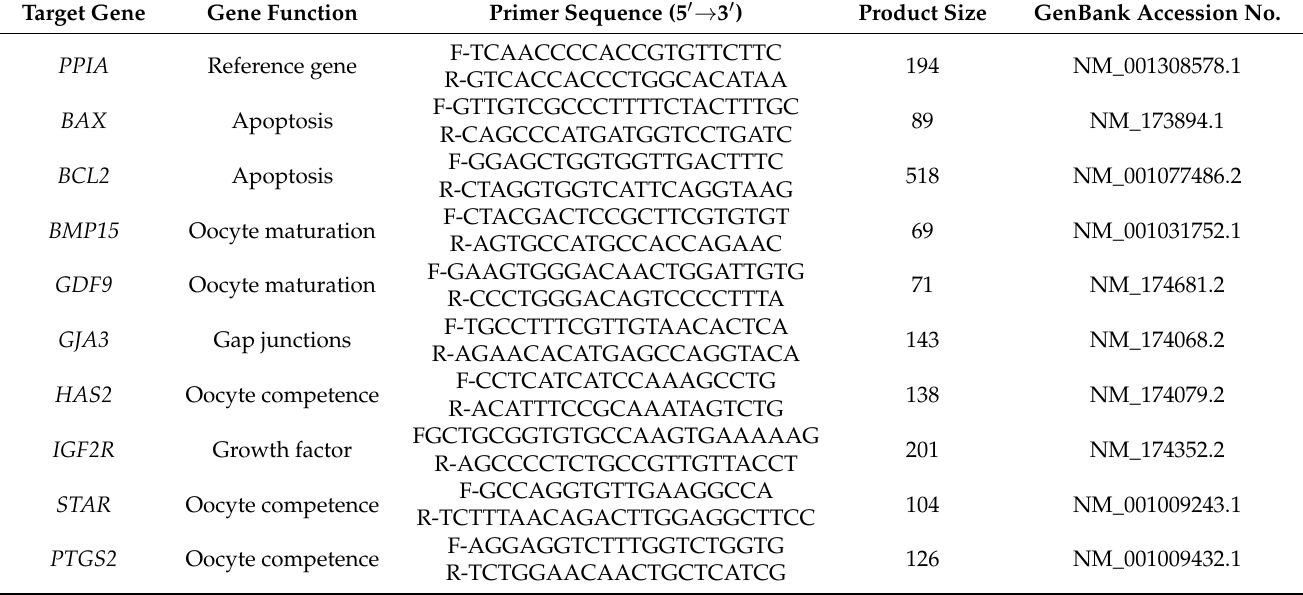
Table 1. The gene-specific primers used for qPCR in oocytes and cumulus cells. Target